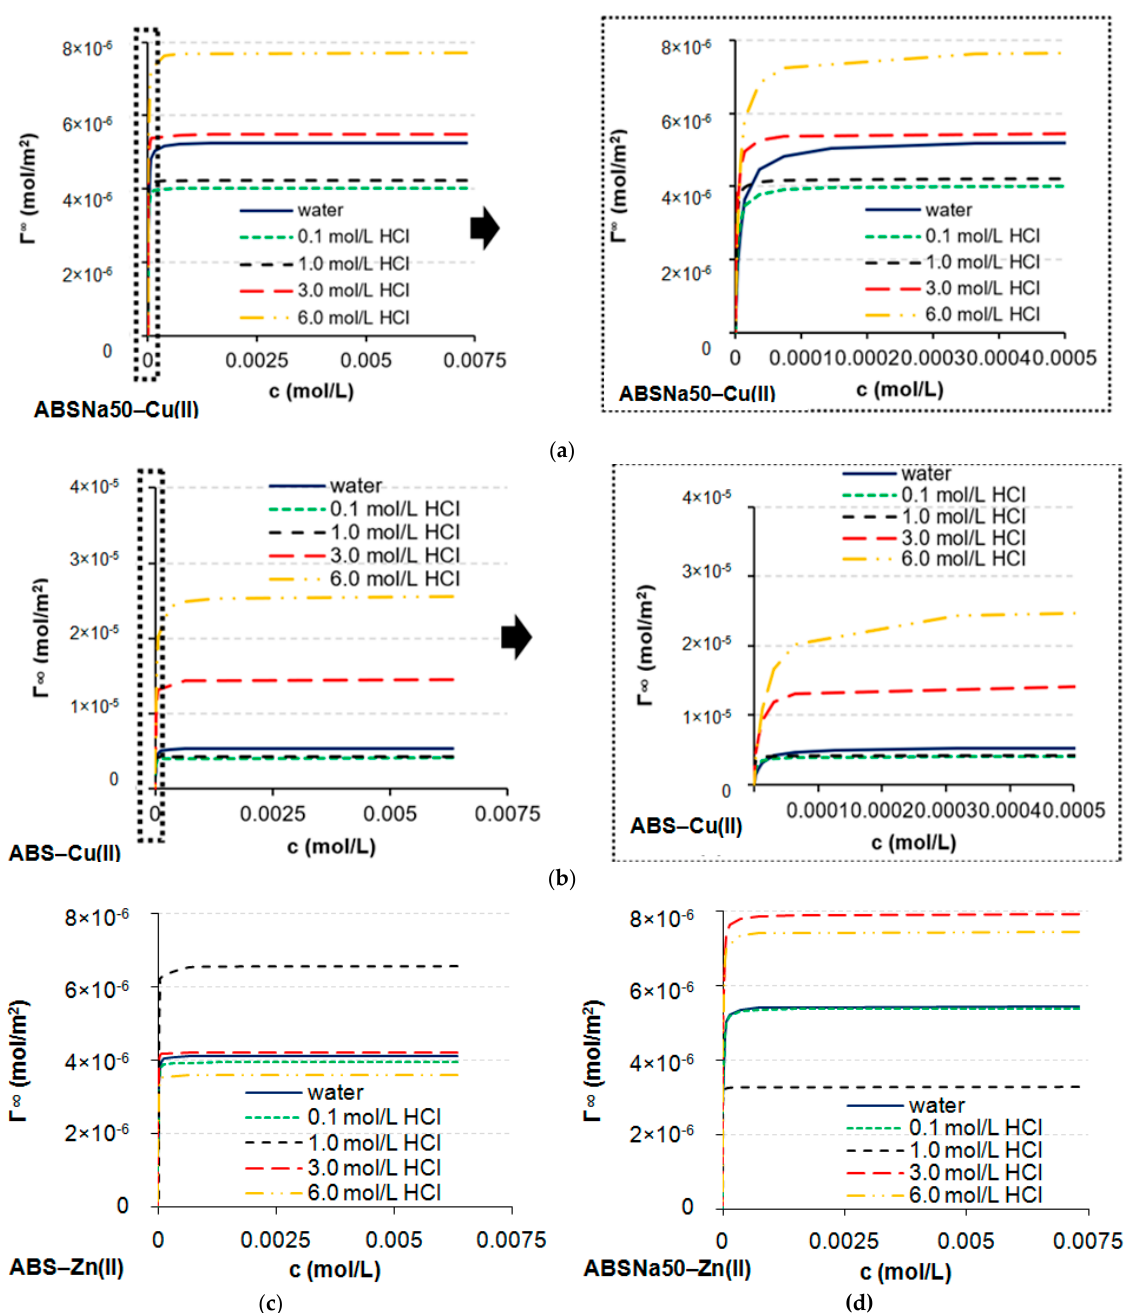
Figure 6. Relations between the Γ ∞ versus concentration of surfactants: ( a , d ) ABSNa50 and ( b , c ) ABS in the presence of Cu(II) ( a , b ) and Zn(II) ( c , d ). Table 2. Adsorption parameters obtained in the water–AS–M(II)/air or HCl–AS–M(II)/air systems.